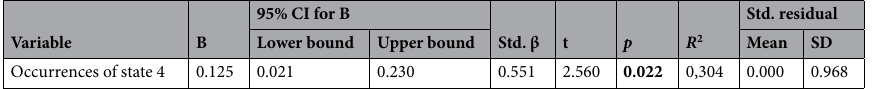
Table 2. The final regression model statistics. Significance values are in